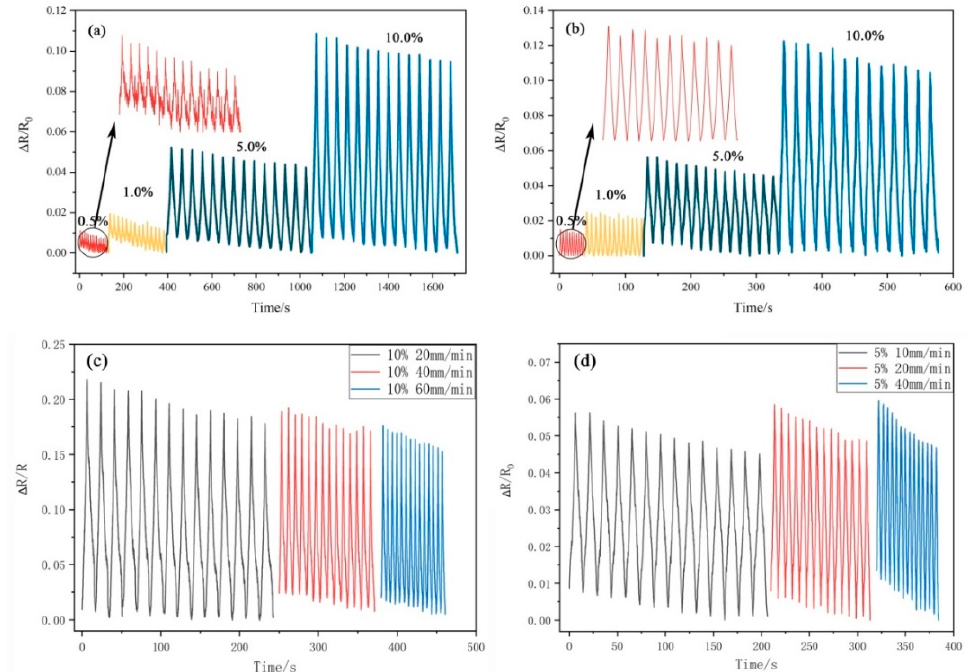
Figure 7. Tensile strain response of the CA/TPU film before and after graphene anchoring. ( a ) Resistance response curves of rGO@ CA/TPU under different strains; ( b ) resistance response curves of rGO/GO@CA/TPU under different strains; ( c ) resistance response curves of rGO/GO@CA/TPU at different stretching rates under 10% strain; ( d ) resistance response curves of rGO/GO@CA/TPU at different stretching rates under 5% strain. Table 3. The maximum strain sensitivity coefficient of each cellulose-based conductive film with different strain